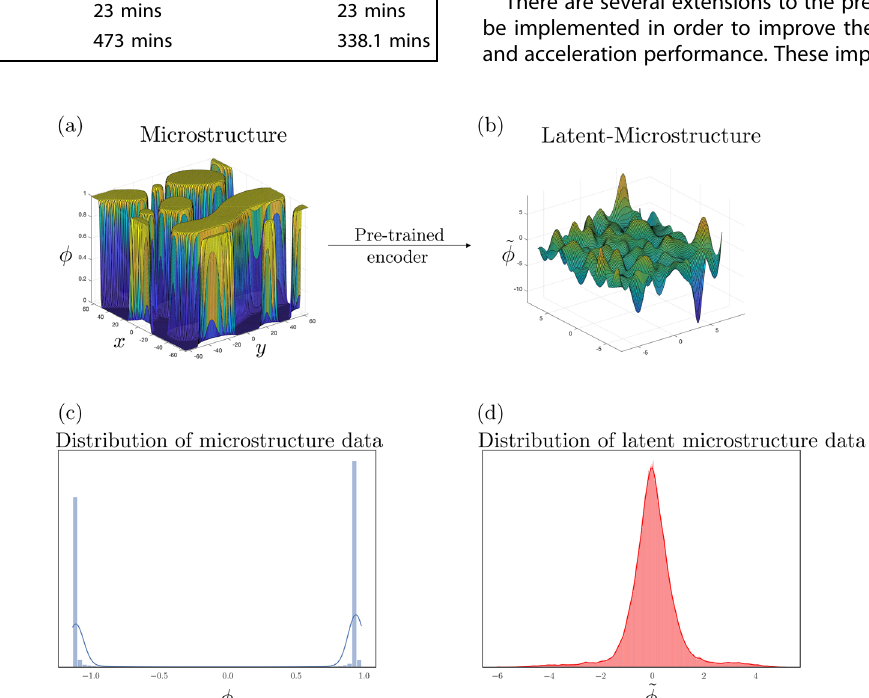
Fig. 7 Representation of microstructure data and statistical insights. a represents a 3D visualization of the function to be approximated by the surrogate model. The presence of several high-gradient regions at every time-step, makes it challenging for neural network models to learn the evolution dynamics of microstructures. Panel ( b ) represents a smoother latent-microstructure learned by the encoder during the autoencoder training. c The microstructure data, ϕ ( x , y , t ), is predominantly represented by 1s or 0s. d The encoder transforms ϕ to a latent space, ~ ϕ , where deep neural networks can learn easily. The curves in ( c ) and ( d ) represent the smoothed density estimates of the